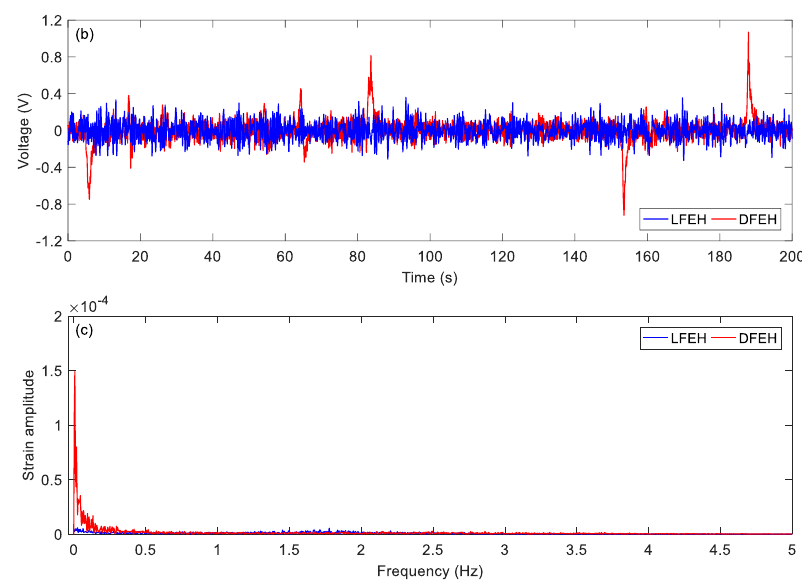
Figure 9. ( a ) Time histories of strain response, ( b ) time histories of voltage response, ( c ) spectrum of dynamic strain response ( v = 2.0 m/s). dynamic strain response ( v = 2.0 m / s).